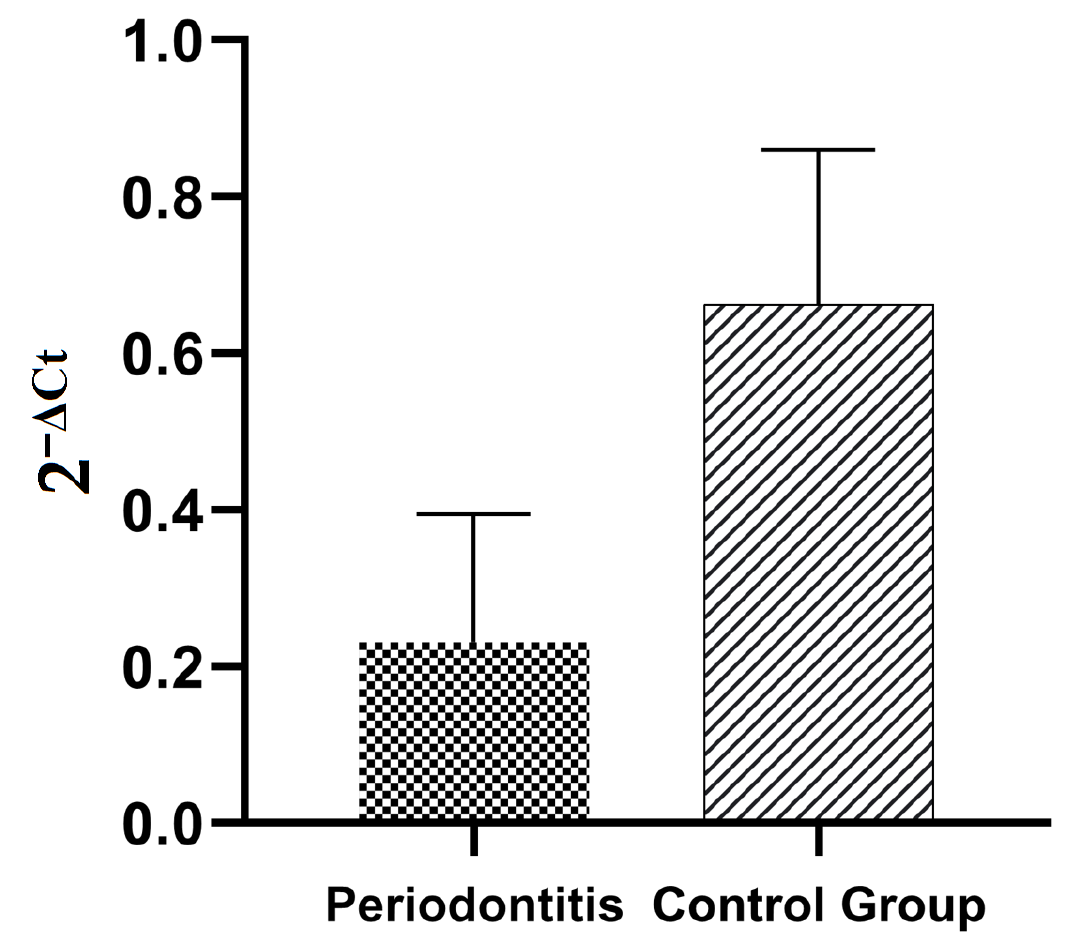
Figure 1. IL-18 expression in gingival tissue in patients with periodontitis and the control group, p -0.0008. Table 9. Correlations between IL-18 gingival expression and the selected clinical parameters in patients with periodontitis.